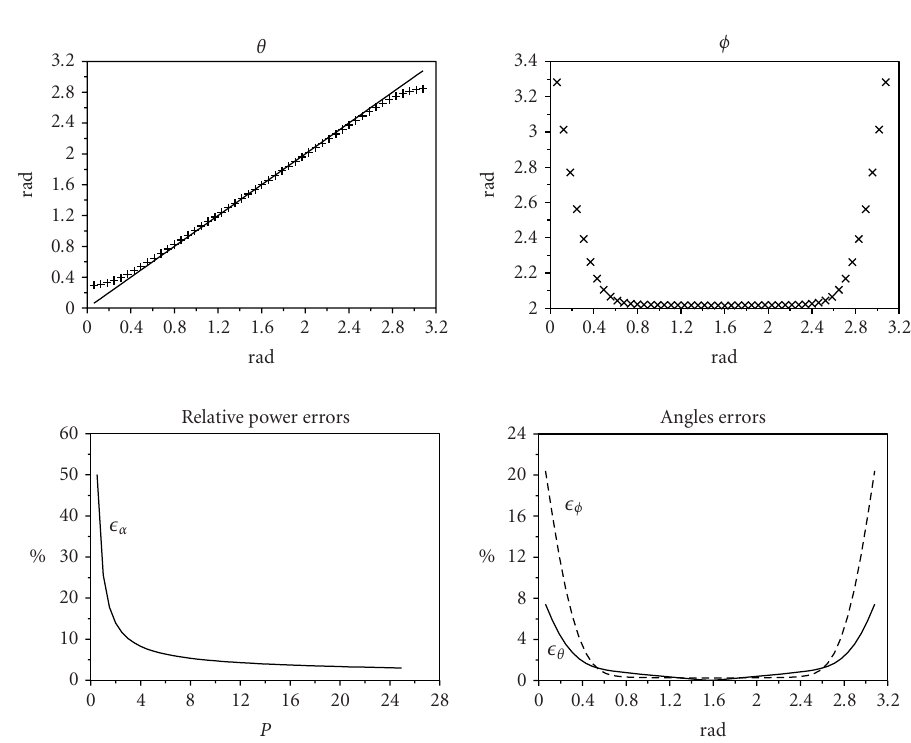
Figure 6.2. Variation of the average direction ¯ θ (plotted with +, the true value is the solid line), ¯ φ (plotted with × ), and errors (cid:1) θ , (cid:1) φ for a Dirac with P = 8, φ d = 2, and θ d varying from 0 to π . The plot named “relative power error” show the variation of (cid:1) α for a Dirac with θ d = 1 . 5, φ d = 2 and P varying from 0 . 5 to 25.